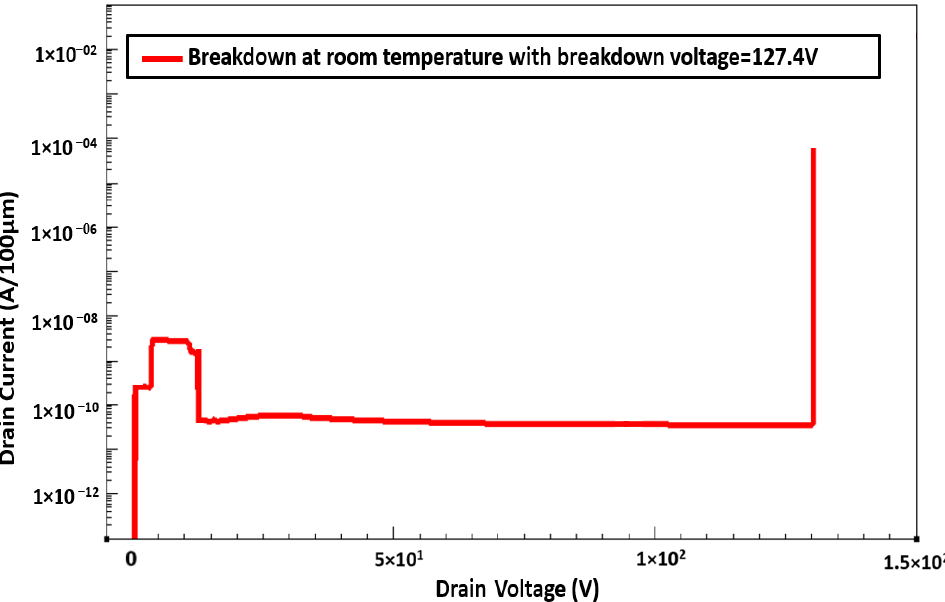
Figure 9. Breakdown Curve at room temperature .